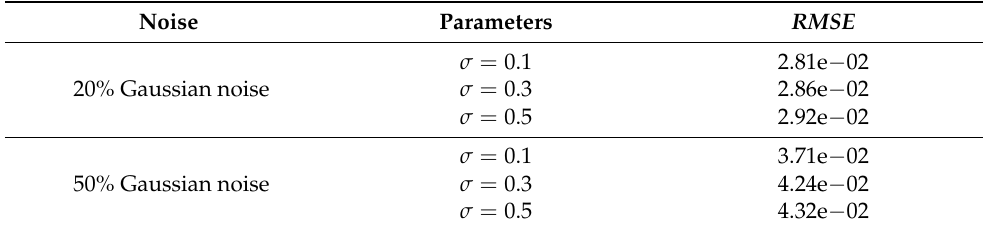
Figure 13. Noise test. The three types of data in the figure represent the input data (in red), recon- struction result (in yellow) and effective region (in green). Table 5. The information of noise